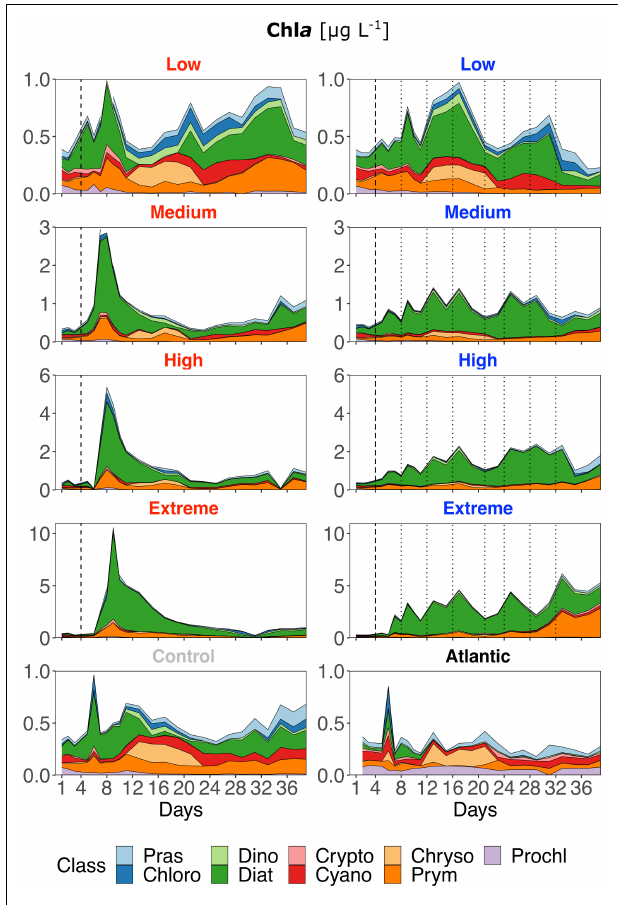
FIGURE 4 | Contribution of each phytoplankton class to total Chla based on Chemtax analysis of photosynthetic pigments (HPLC). Note the different y-axis scales. Abbreviations stand for: Prasinophyceae , Chlorophyceae , Dinophyceae , Cryptophyceae , Chrysophyceae , Prymnesiophyceae , Prochlorophyceae , Cyanophyceae , and Diatomea . Atlantic refers to samples taken from the water surrounding the mesocosm field. Dotted lines represent DW additions, dashed line marks the single DW addition to singular treatments. Red labels represent singular and blue labels recurring